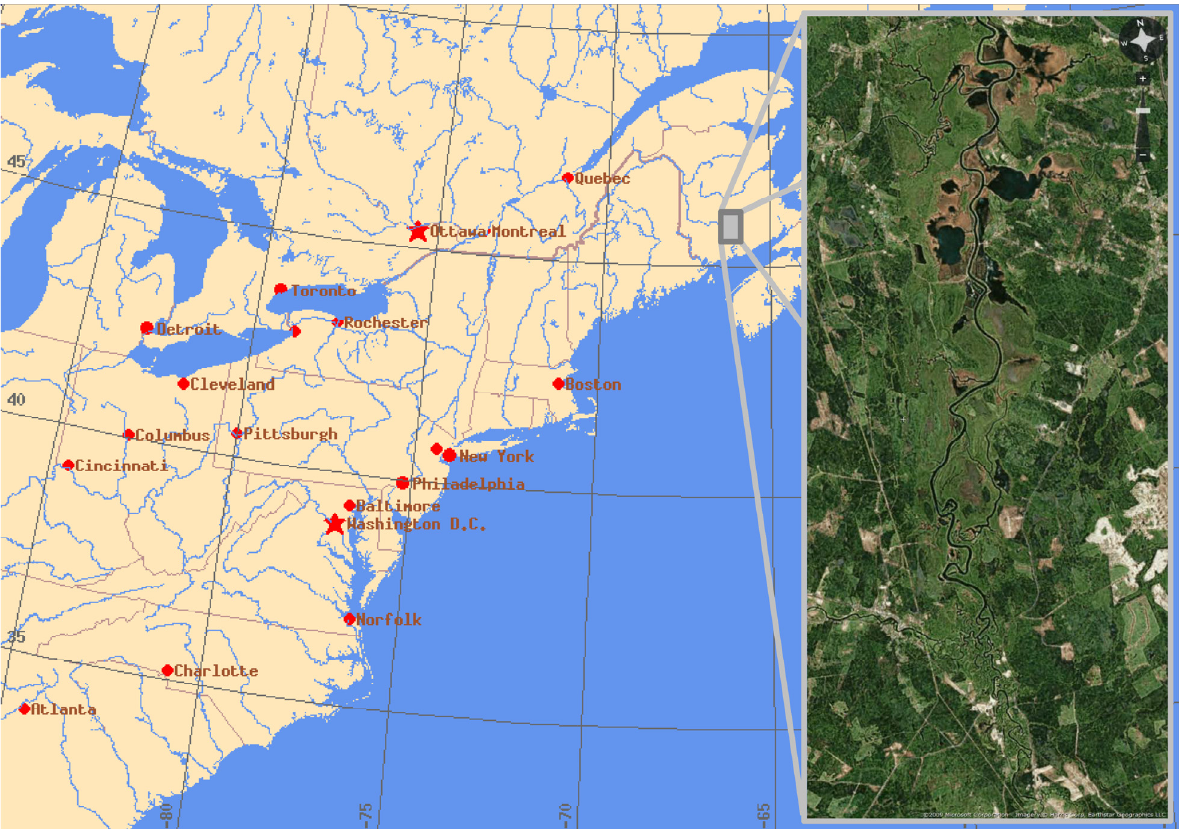
Figure 1. Location map (EOWEB ® ) and optical image (©2009 Microsoft Corporation, Redmond, WA, USA; Imagery © Harris Corp, Melbourne, FL, USA; Earthstar Geographics LLC, San Diego, CA, USA; NAVTEQ, Chicago, IL, USA) of the study area near Gagetown, New Brunswick,